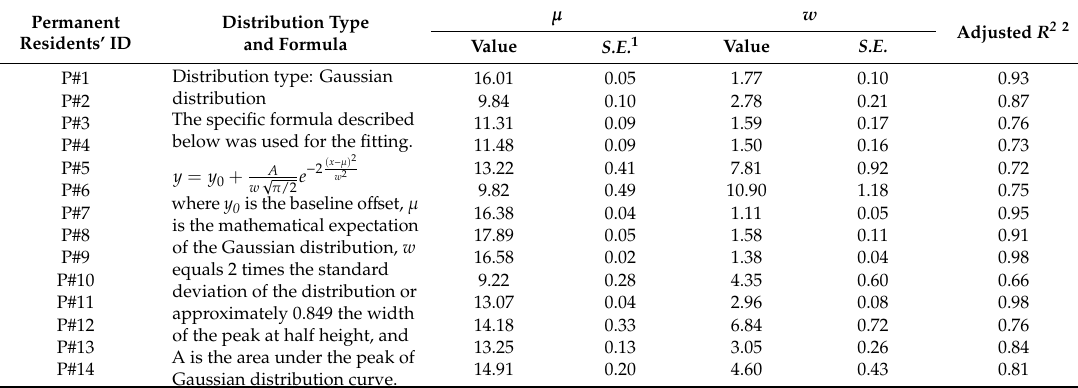
Table 5. Personal experienced temperature distribution for each